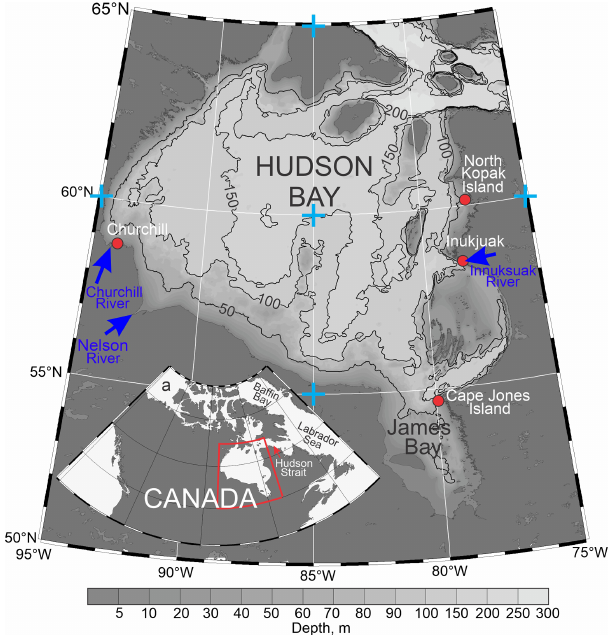
Figure 1. Map of Hudson Bay. Red dots depict the permanent tide gauge in Churchill and temporary tide gauges in Inukjuak, Cape Jones Island and North Kopak Island. Blue arrows highlight Churchill, Nelson, and Innuksuak river mouths. Blue crosses depict the five-point stencil used for computing atmospheric vorticity ap- proximated as Laplacian from sea-level atmospheric pressure. The numbered black lines depict depth contours of 50, 100, 150, and 200m. (a) Inset shows the Hudson Bay location within North Amer- ica. The map of Hudson Bay was compiled based on the General Bathymetric Chart of the Oceans (GEBCO, https://www.gebco.net/, last access: 30 September